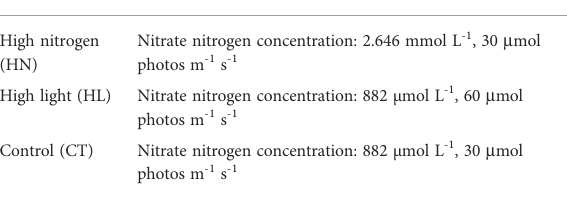
TABLE 1 Treatment conditions of A. paci fi cum